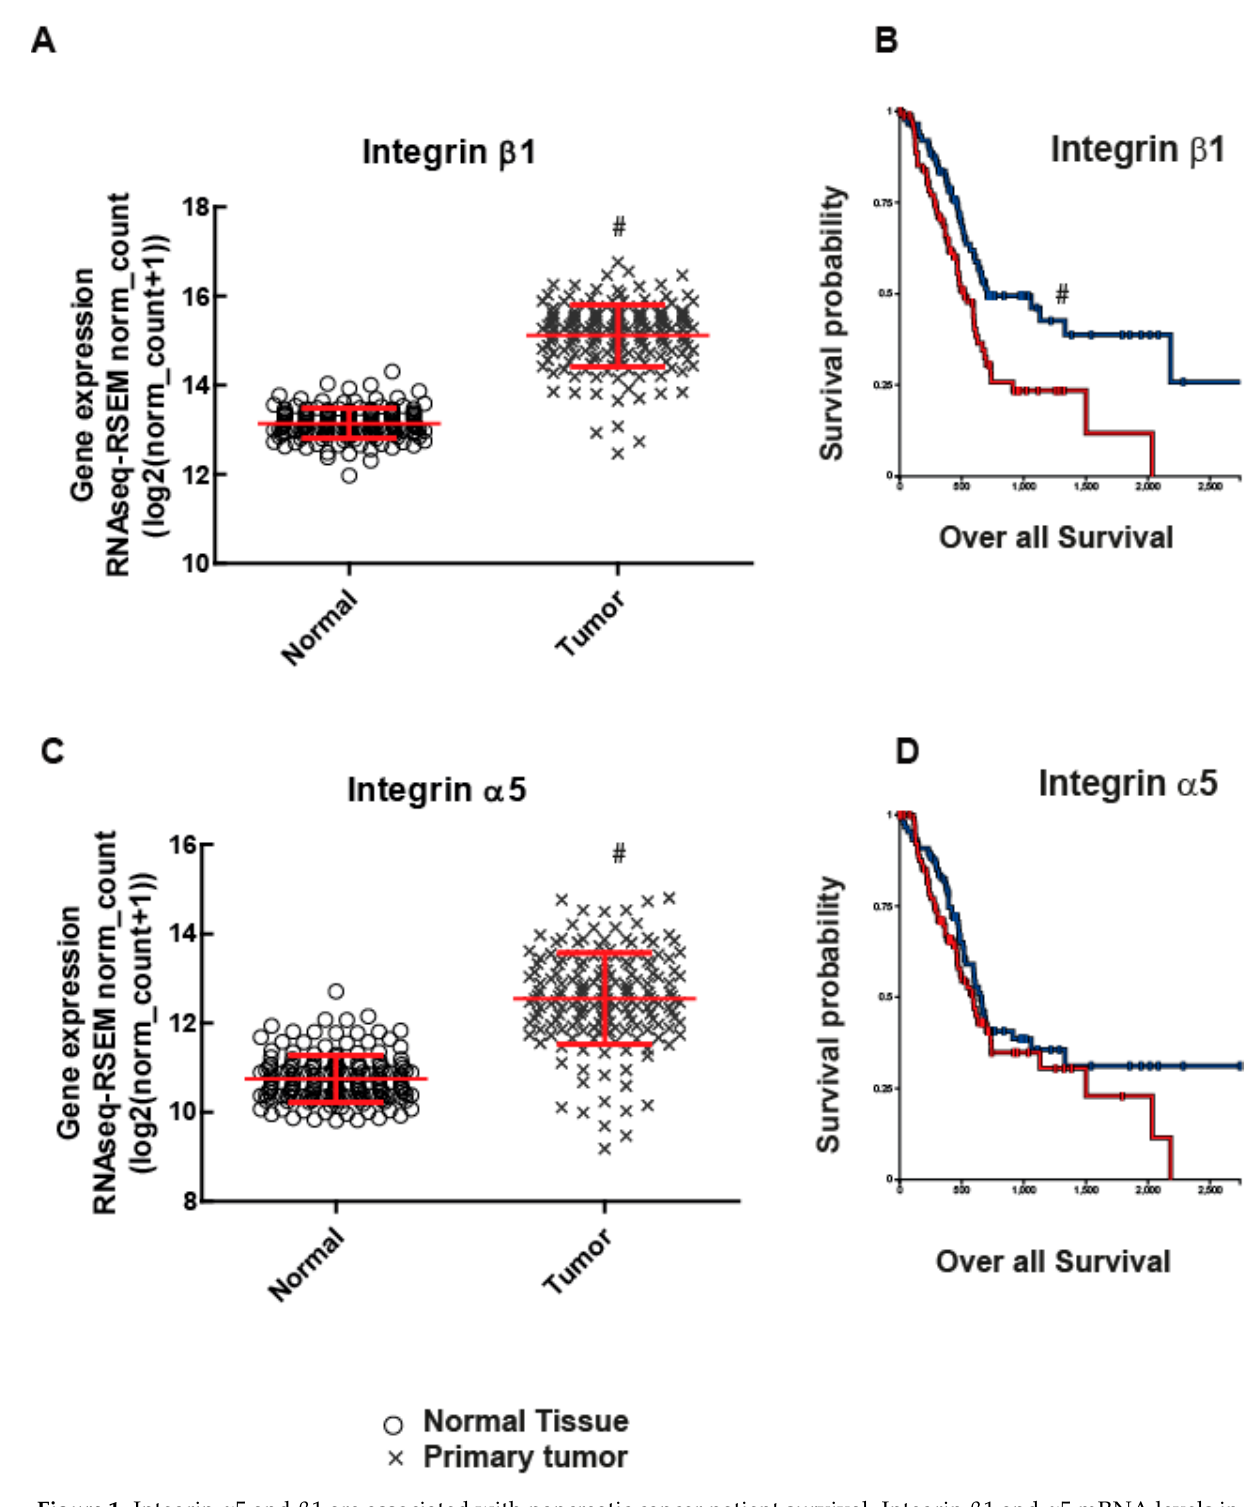
Figure 1. Integrin α 5 and β 1 are associated with pancreatic cancer patient survival. Integrin β 1 and α 5 mRNA levels in primary tumors were compared with normal tissue using TCGA data. ( A ) Primary tumors have higher gene expression of integrin β 1 than normal tissues (# p < 0.0001, n = 165 for normal and n = 178 for tumors) red lines indicate the mean and SD of the values. ( B ) Increased expression of integrin β 1 (red lines) associates with lower survival in patients as depicted by KM plot p < 0.001. ( C ) Integrin α 5 also has higher gene expression than normal tissues (# p < 0.0001, n = 165 for normal and n = 183 for tumors). ( D ) Integrin α 5 did not show a clear relationship with patient survival p > 0.05.